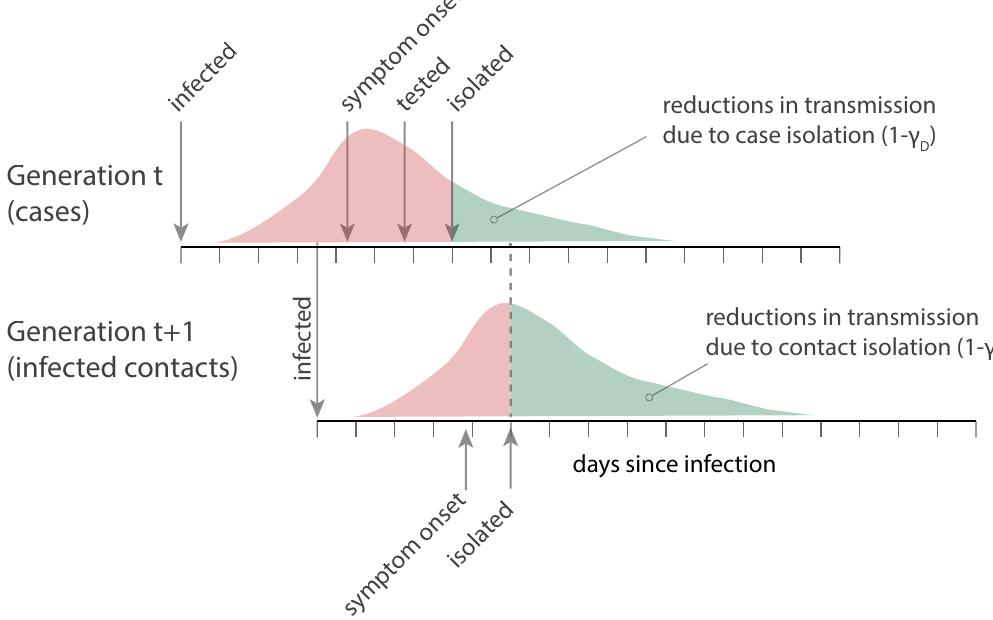
Fig 2. Conceptual representation of test-trace-isolate programs, where detection of a case in generation t through widespread testing and subsequent isolation reduces onward transmission to generation t+1 . Individuals in generation t+1 are then traced and quarantined (and subsequently isolated, if the contact is a suspected or confirmed case) to reduce onward transmission from those who may be infected.